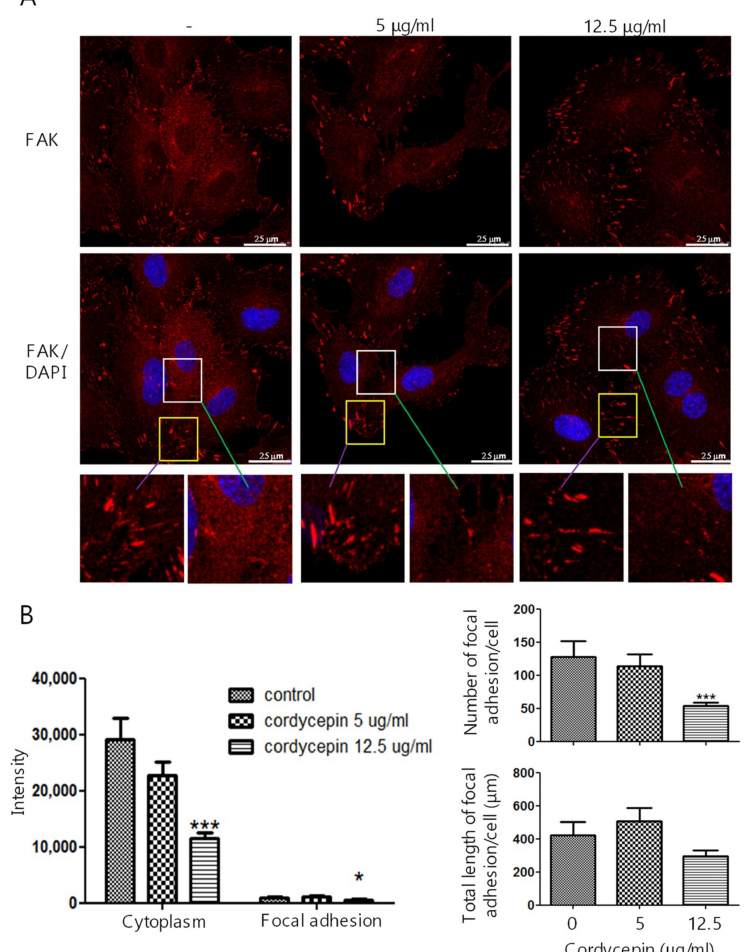
Figure 4. Suppression of the cytoplasmic expression of FAK in HUVECs by cordycepin. ( A ) HUVECs were treated with 0–12.5 µ g/mL cordycepin for 24 h. The expression level of FAK was determined by confocal microscopy. ( B ) FAK expression was quantified based on staining intensity, and number and total length of focal adhesion were determined by using MetaMorph software (Version 7.10.1.161, Leica, Wetzlar, Germany). Scale bars: mean ± SD. *, p < 0.05; ***, p <